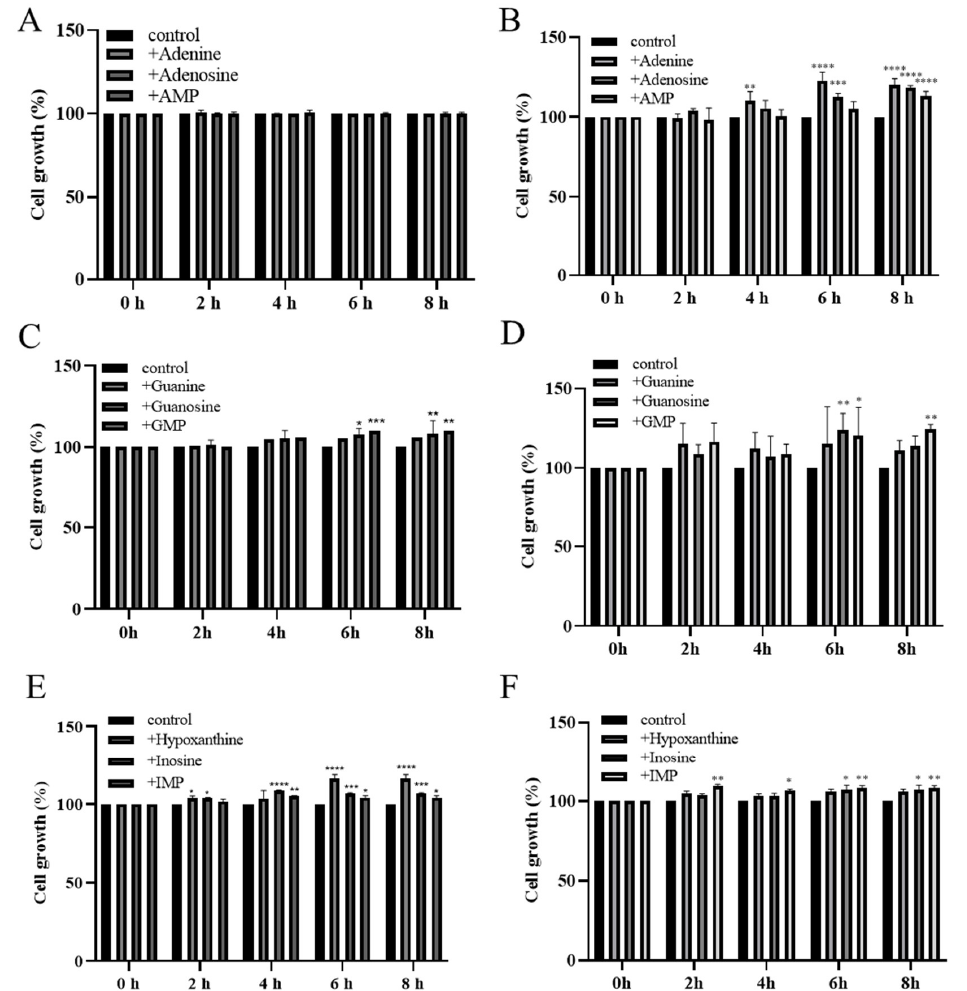
Figure 2. The growths of LAB increased in the medium supplemented with purine nucleotides, nucleosides, and bases. MJM60396 was incubated in the medium supplements with AMP, adenosine, and adenine ( A ), GMP, guanosine and guanine ( C ), IMP, inosine, and hypoxanthine ( E ). MJM60662 was cultured in medium supplements with AMP, adenosine, adenine ( B ), GMP, guanosine and guanine ( D ), IMP, inosine, and hypoxanthine ( F ). Values represent the means ± SD of three samples. * p < 0.05, ** p < 0.01, *** p < 0.001, **** p < 0.0001 compared with